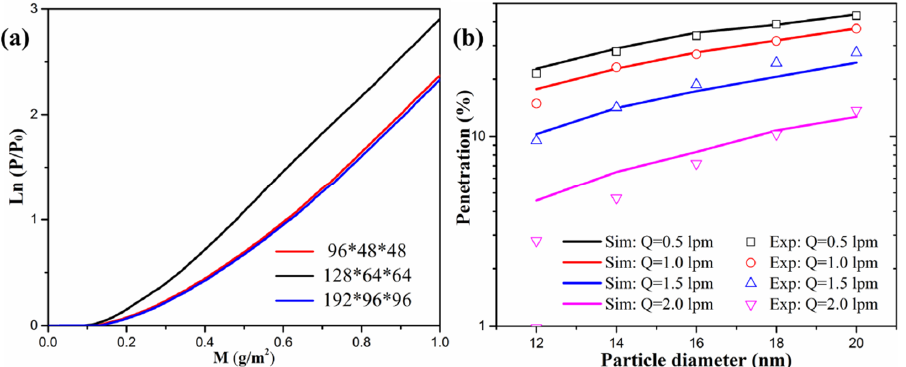
Figure 4. ( a ) Grid sensitivity verification of Case 2; ( b ) comparison between simulated penetration and experimental values [37].